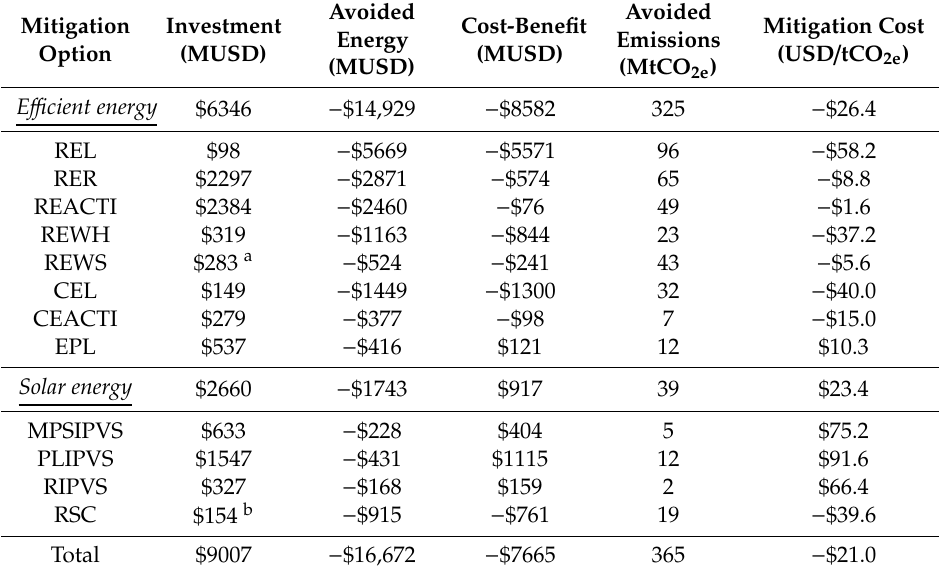
Table 5. Cost-benefit and avoided emissions by energy e ffi ciency and solar energy options in the mitigation